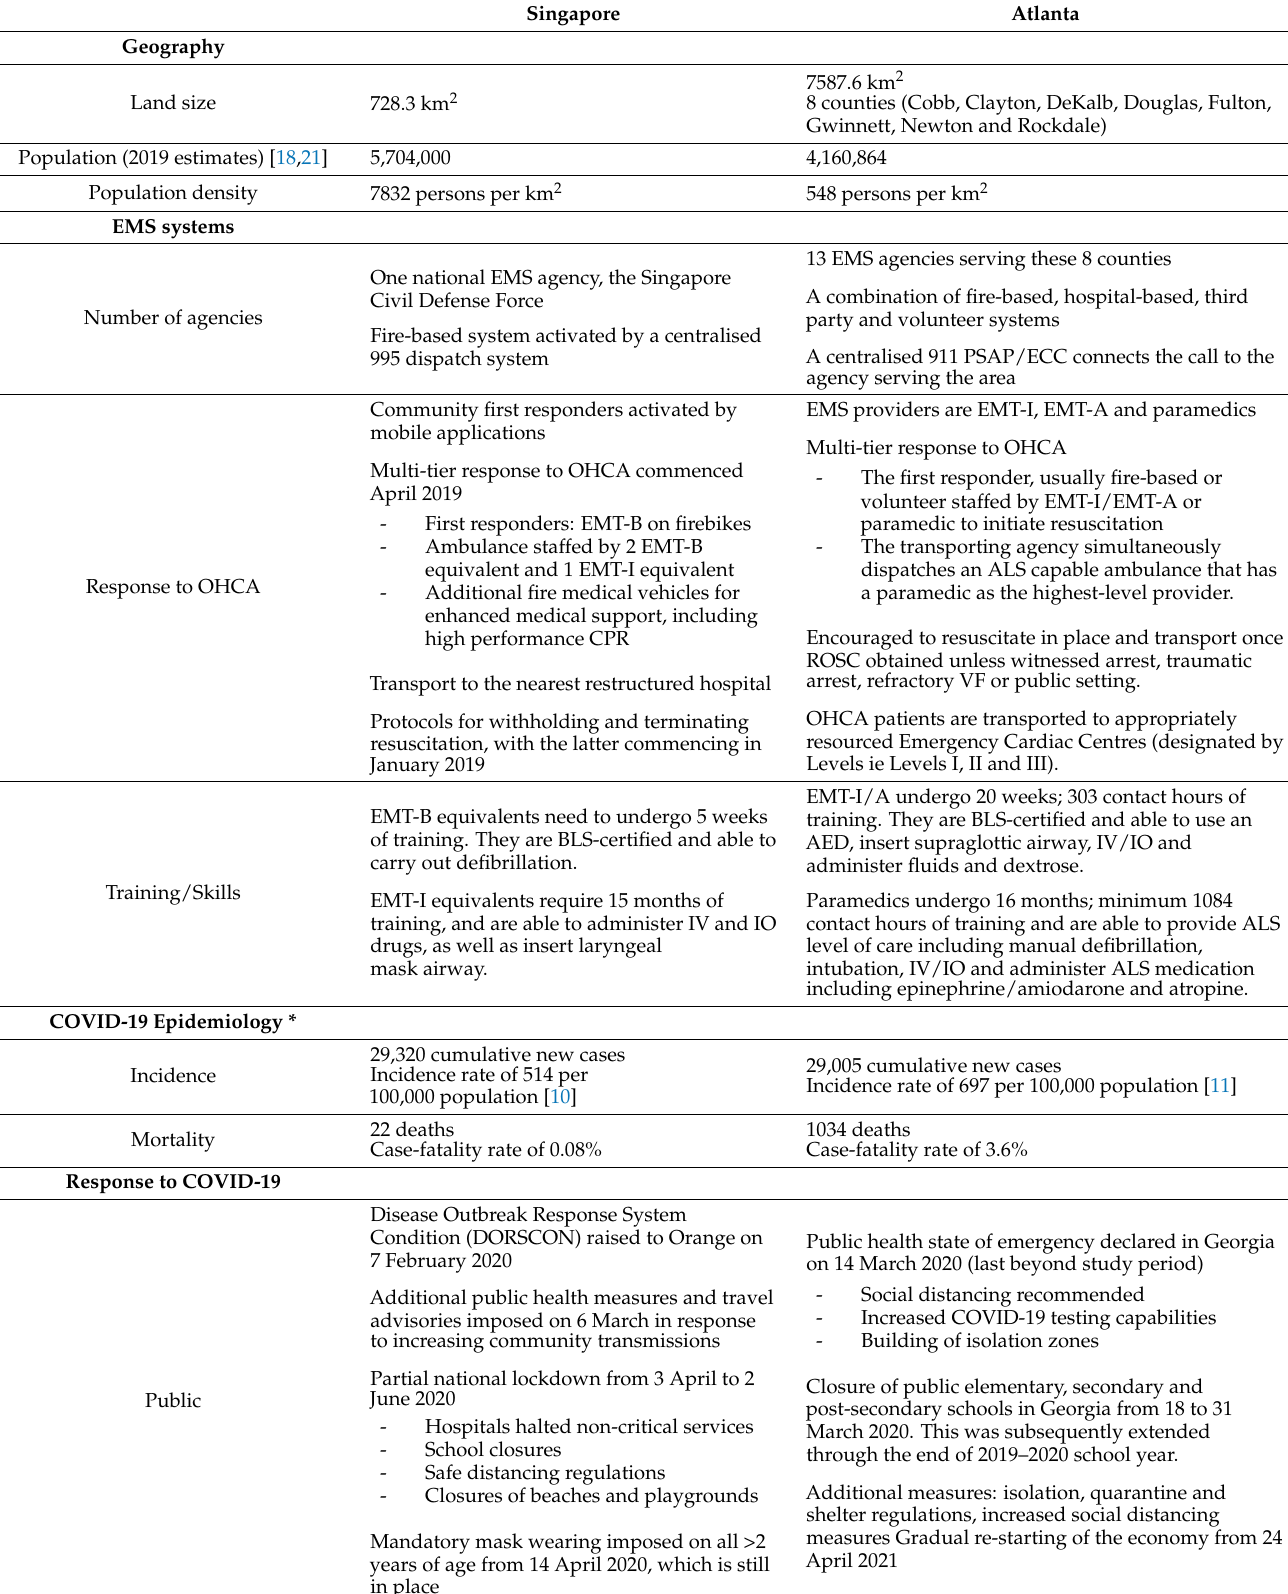
Table 1. Differences between Singapore and